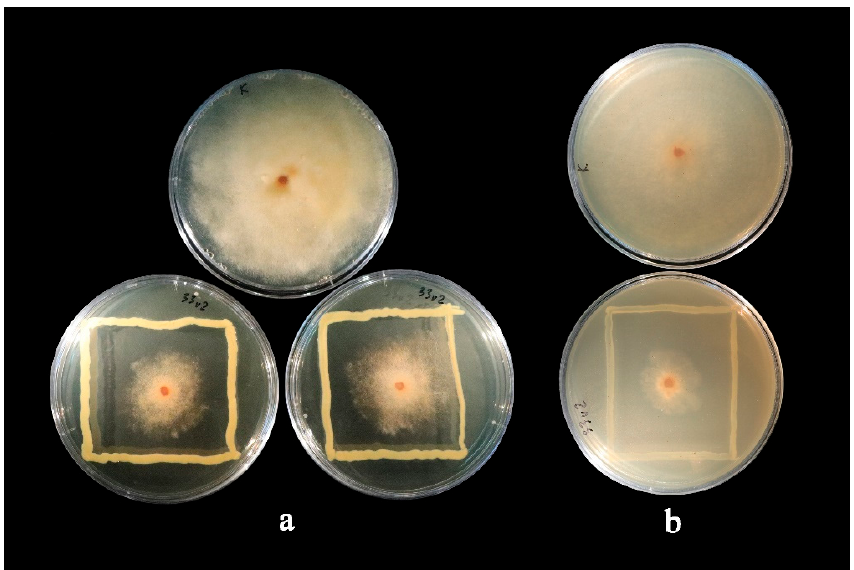
Figure 2. Dual culture antagonism assay of the Monilinia fructigena pathogen and the endophytic bacteria isolate Pseudomonas graminis SENP33v2 from Prunus domestica buds ( a ) on a maltose medium and ( b ) on a Potato Dextrose Agar, as compared with the control plates (shown on top). All endophytes showing antagonistic activity against M. fructigena were identified by 16S rRNA gene sequencing (Appendix A, Table A1). Six of the eight isolates were assigned